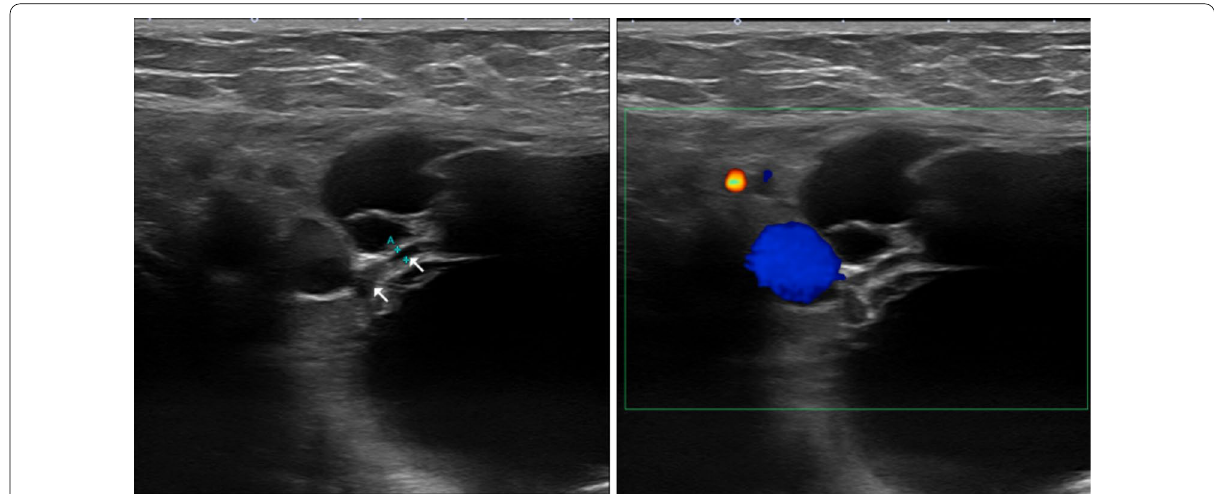
Fig. 3 Breast ultrasonography findings. Breast ultrasonography confirmed a multilobulated cystic mass in the left axial region and branches (arrow) from the mass connected to the axillary vein